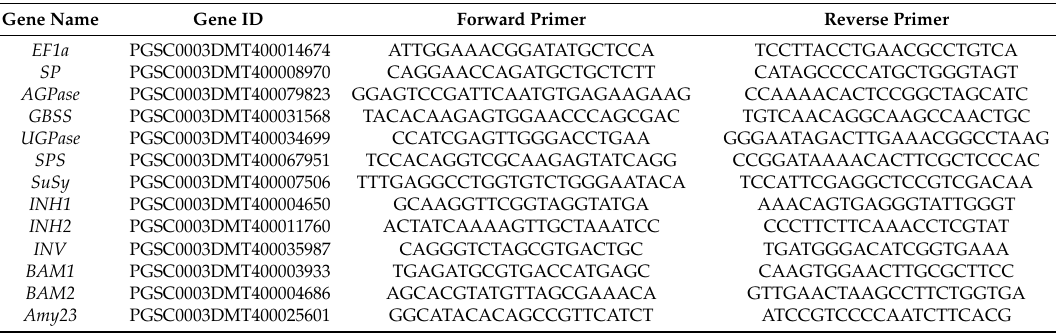
Table 2. Primer sequences used in this